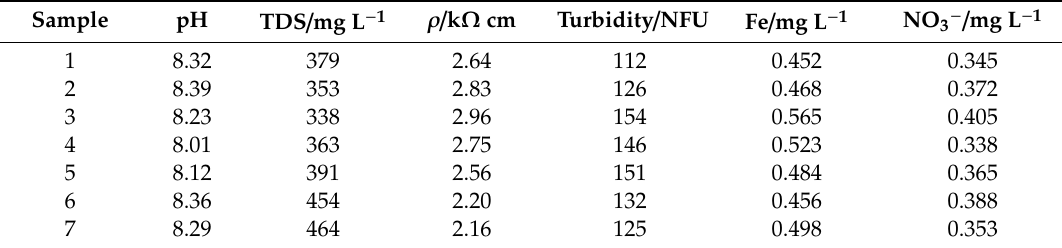
Table 4. Results of the physico-chemical analyses.